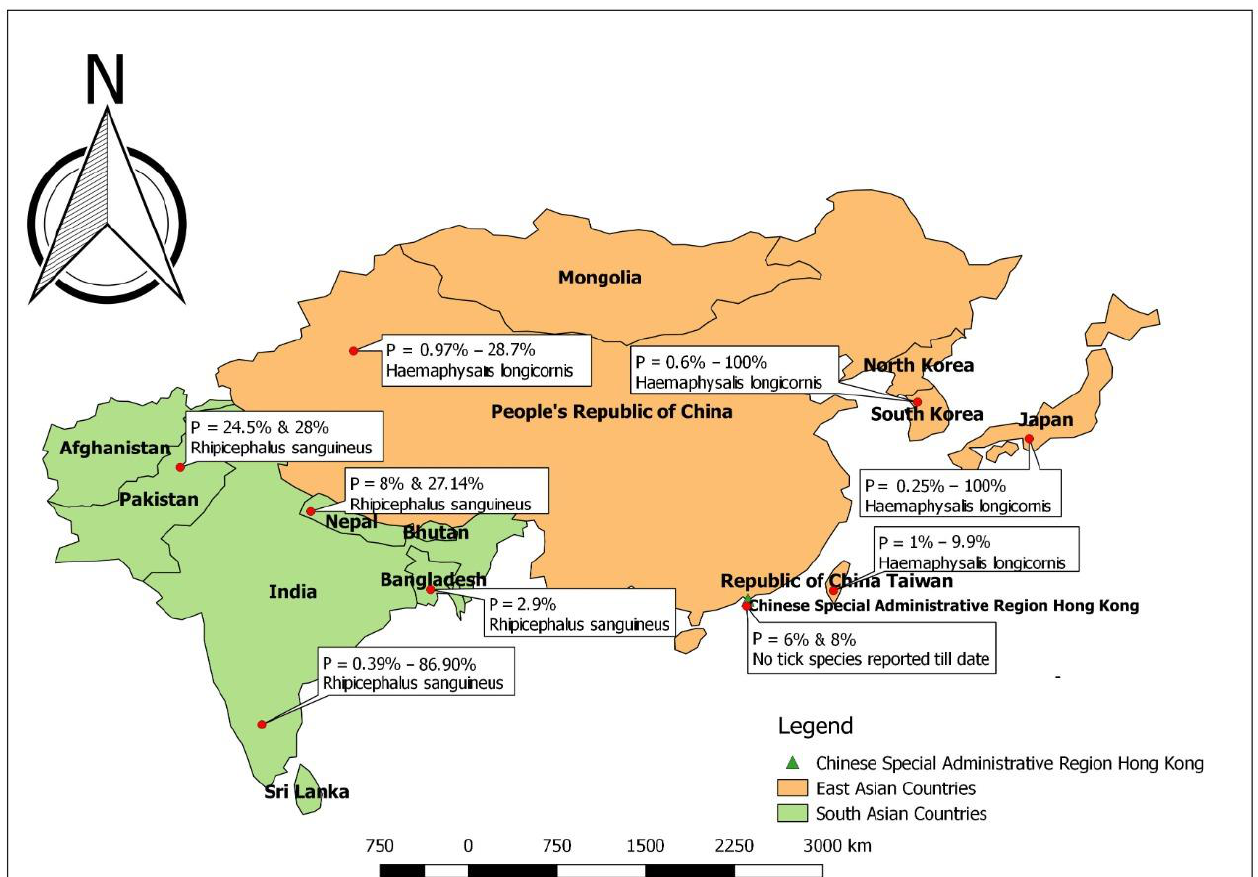
Figure 1. Prevalence percentage and main vector responsible for ehrlichiosis in dogs reported in different countries of east and south Asia.